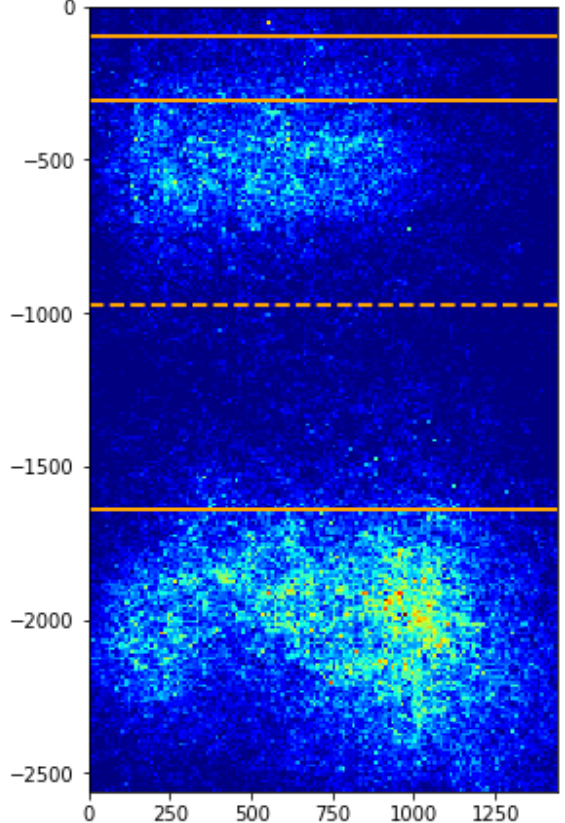
Figure 8. Illustration of the threshold set at 971 px (dotted line) separating the main gaze